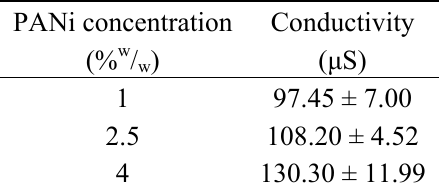
Table 5. Conductivity data for ECH formulations containing varying PANi